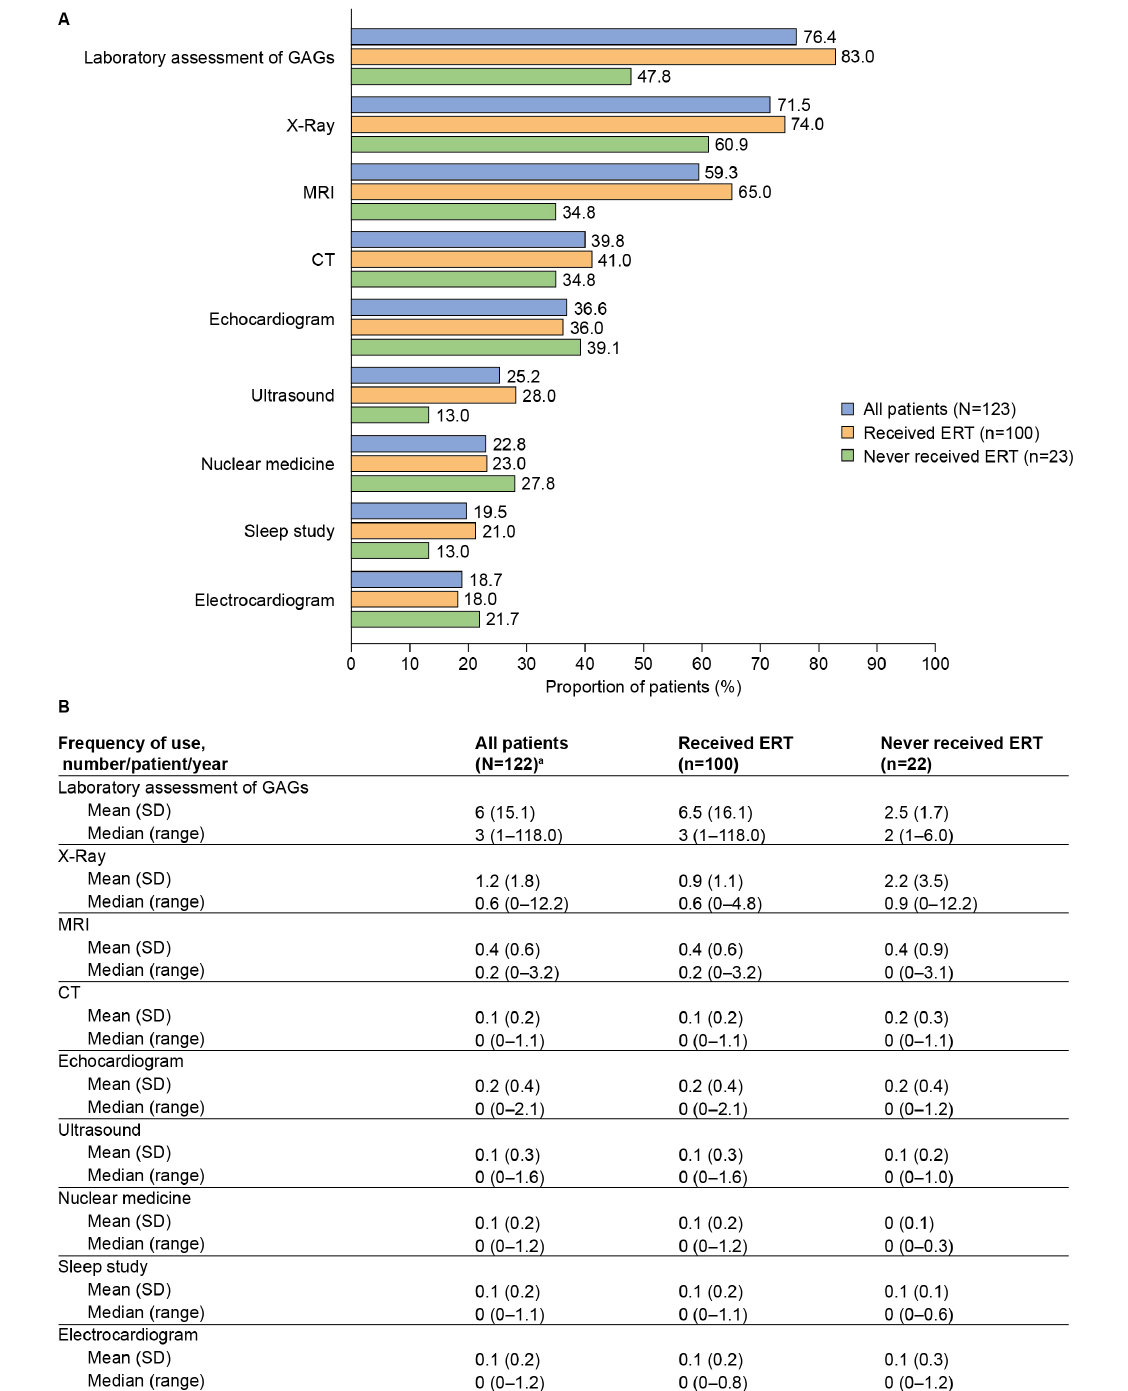
Figure 4. Summary of Lab Assessments of GAGs and Imaging Utilization (Imaging Procedures Performed in >15% of